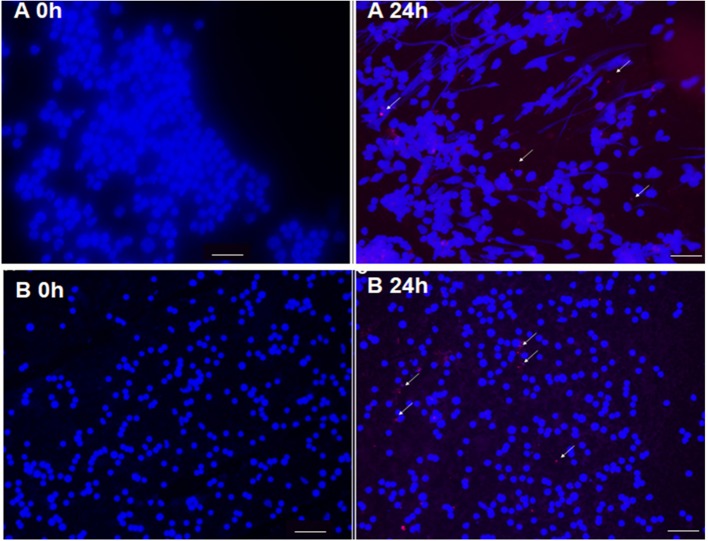
Targeting of liposomes (arrow) labeled with DIL C18 (red) containing sertraline in spleen (A) and liver (B) of BALB/c mice. Ten days after infection, the animals were treated with LP-SERT, spleen and liver were removed, imprinting of each organ have been made in slides, and the samples were submitted to immunofluorescence analyses at 24 h. Nucleated cells were labeled with DAPI (blue). White bars represent 50 μm.